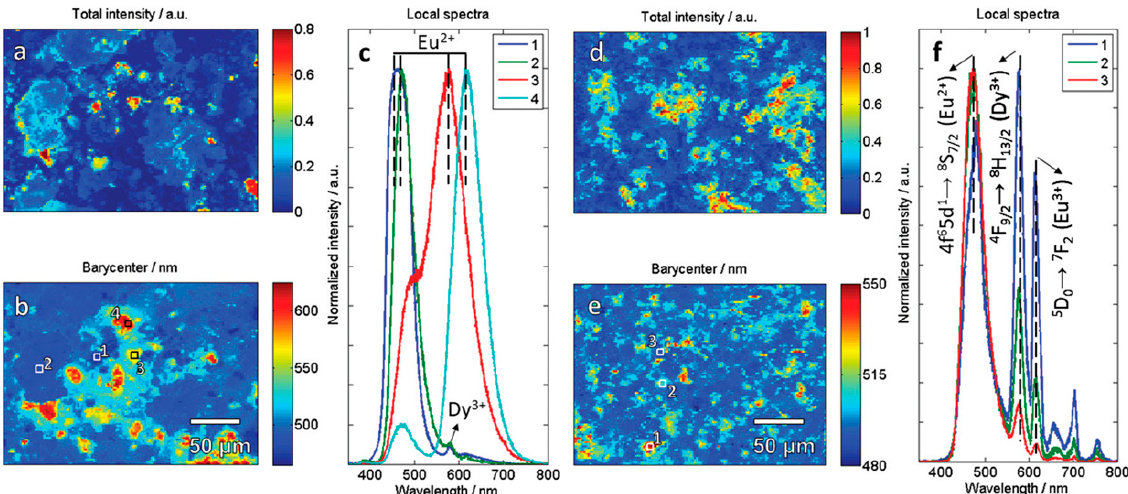
Figure 12. SEM-CL hyperspectral images of the Sr 2 MgSi 2 O 7 :Eu 2+ (1%), Dy 3+ (1%) materials obtained by CSS ( a , b ) and MASS ( d , e ) method. The numbers in the images ( b , e ) correspond to the area of the local spectra extracted for the CSS ( c ) and MASS ( f ) materials. Reproduced from Ref. [57] with permission from The Royal Society of Chemistry.